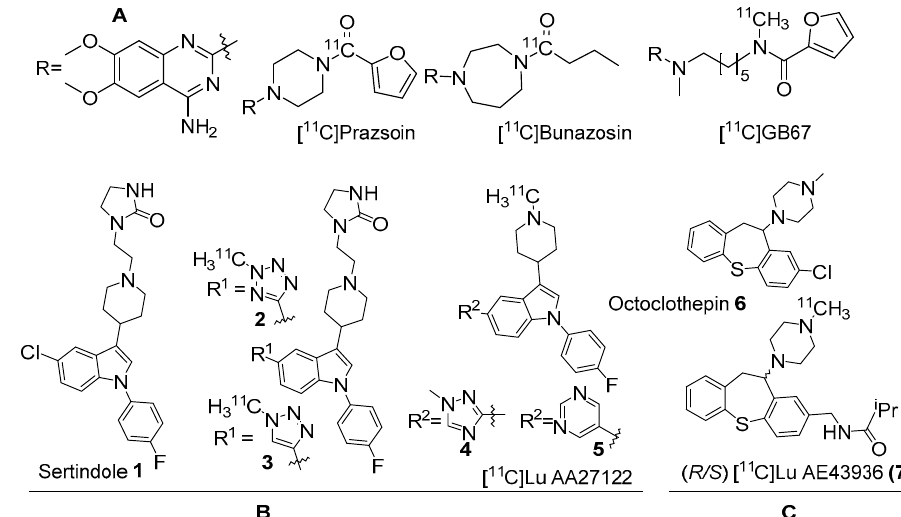
Figure 1. ( A ) Earlier PET radiotracers, [ 11 C]Prazosin, [ 11 C]Bunazosin, and [ 11 C]GB67 for cardiac α 1-AR imaging. ( B ) Antagonist PET radiotracers based on sertindole. ( C ) Antagonist PET radiotracers based on octoclothepin for brain α 1-AR imaging.